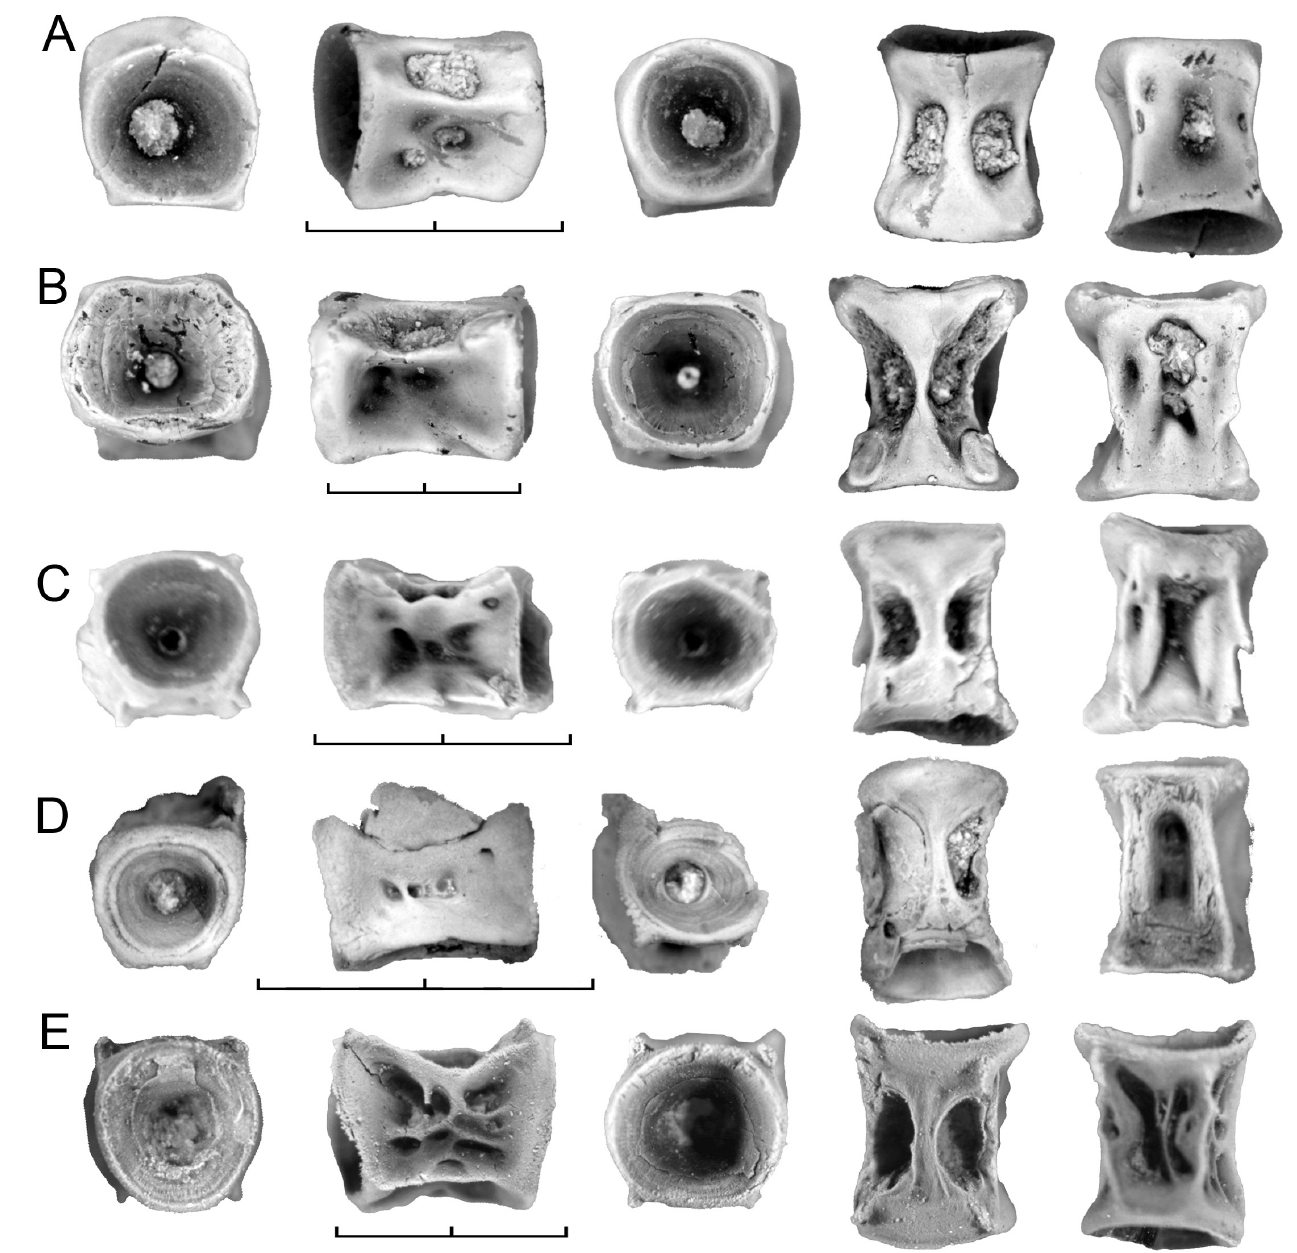
Figure 11. Centra morphotypes HvB from the Milk River Formation compared with specimens from the Belly River Group, Smokey Hollow Member of the Straight Cliffs Formation of Utah, and Wasatch Formation of Wyoming. A, B) centrum morphotype HvB from the Milk River Formation, showing variation in the development of the neural arch articular pits; A, specimen UALVP 48899; B, speci - men UALVP 48901. C) Centrum morphotype HvB from the Dinosaur Park Formation of Alberta, specimen TMP 2000.22.11. D) Centrum morphotype HvB from the Smokey Hollow Member of the Straight Cliffs Formation of Utah, specimen OMNH 31322. E) Weberian centrum (UCMP V198889 IIIa) of the Wasatch Formation gonorynchiform. C and D from Brinkman et al. (2013: Fig. 10.26) E from Divay and Murray (2016: fig. 4A). Centra shown in anterior, left lateral, posterior, dorsal and ventral views. Scale bar equals 2